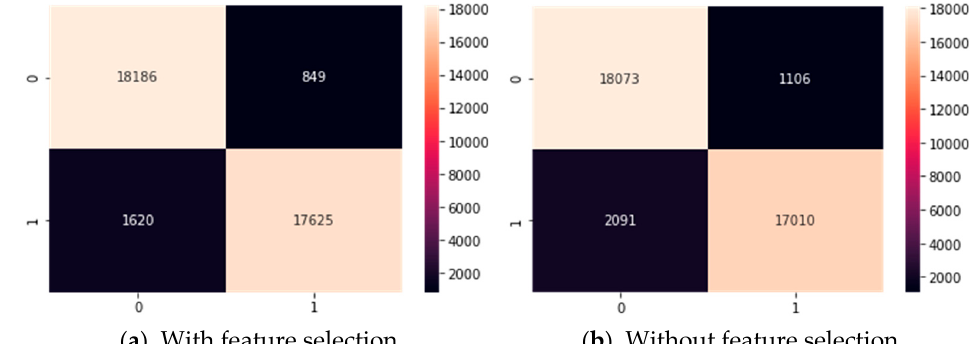
Figure 12. Confusion matrix of KNN